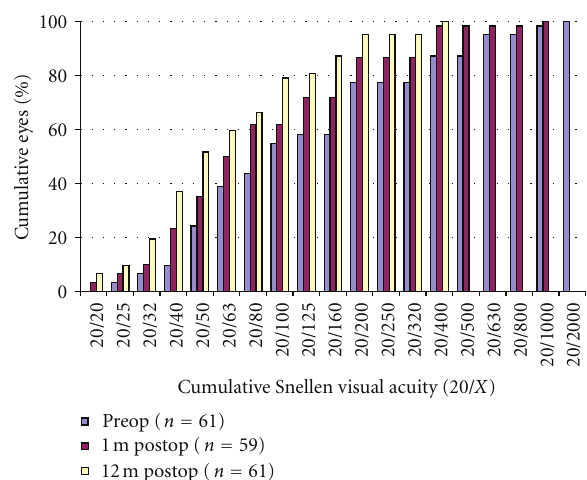
Figure 2: UDVA 1 months and 12-months after the epithelium-on CXL.